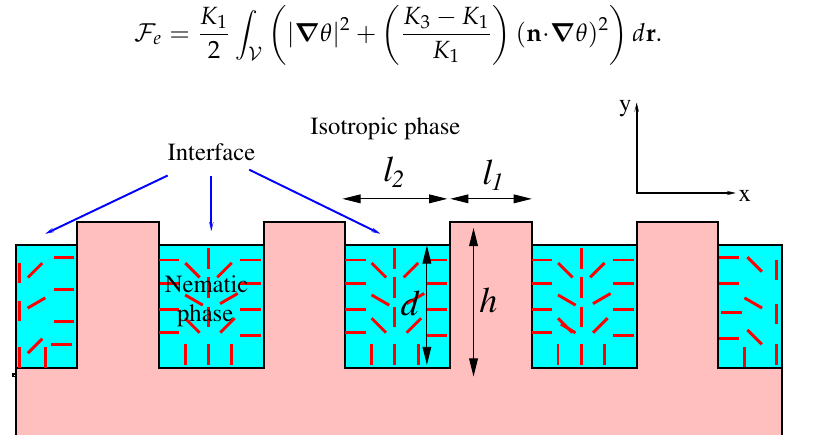
Figure 1. Schematic picture of an interfacial configuration of a nematic layer of thickness d (in green) at coexistence with a bulk isotropic liquid (in white) on a crenellated substrate with depth h and length scales l 1 and l 2 . The nematic–isotropic interface and the director field in the nematic phase (in red) are also